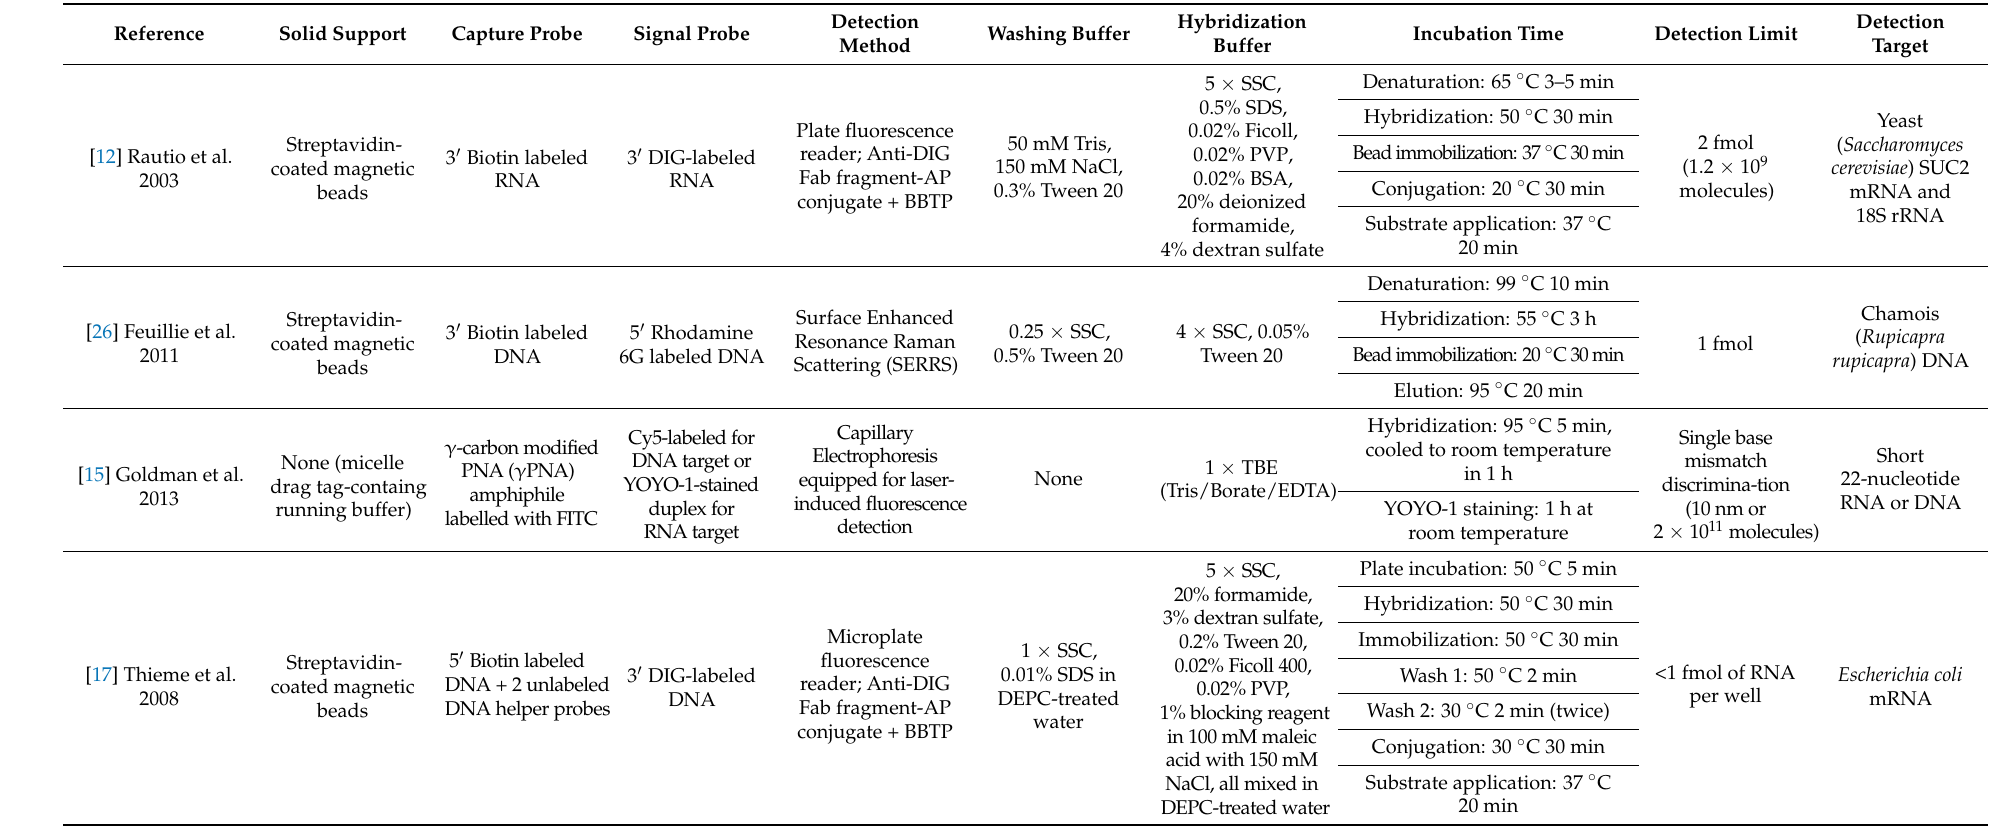
Table 1. Representative applications and methodological variations of sandwich hybridization assays reported in the